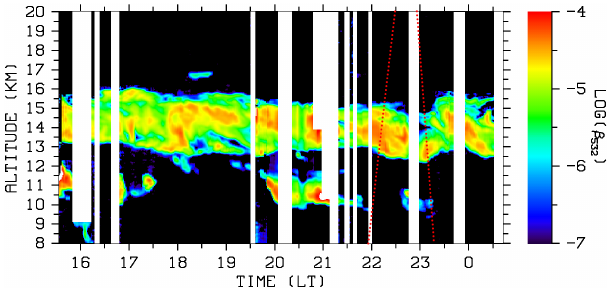
Fig. 9. Time-height section of the backscattering coefficient (m − 1 str − 1 ) at 532 nm observed by the Biak lidar. Red dotted lines: superposed ascending and descending sonde flight tracks. White bands: periods with low data quality. Local time at Biak shown in abscissa is GMT + 9. The range in which the COBALD BSR exceeds 10 in Fig. 8 corresponds to altitudes between 13.2 and 15.0 km .